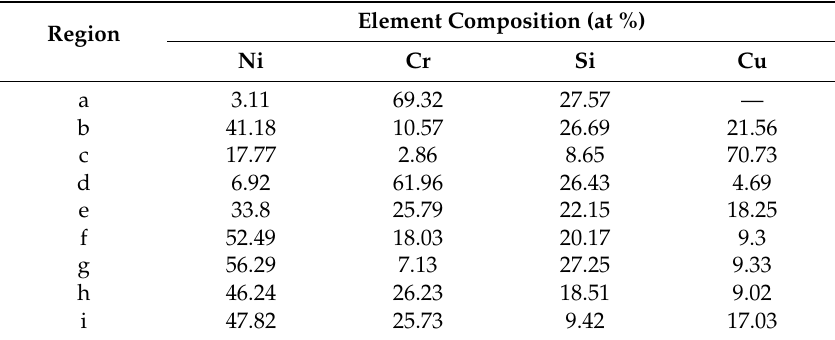
Table 3. Energy dispersive spectrometer (EDS) analyses of test points in coatings.